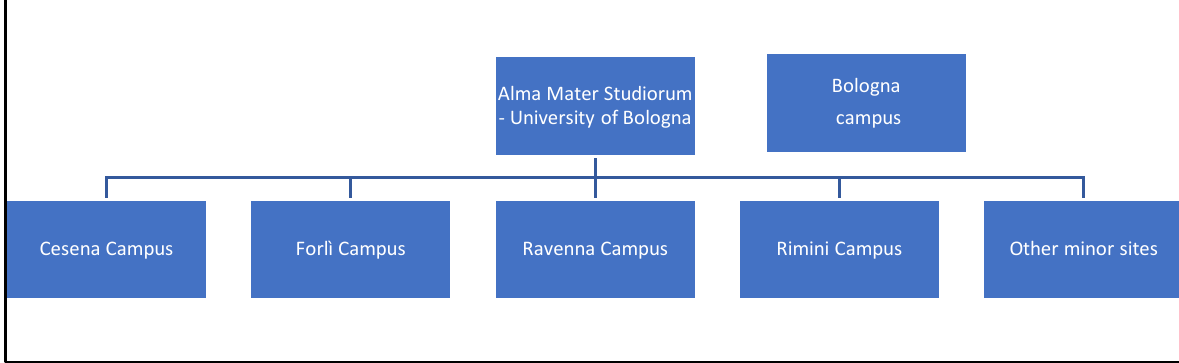
Figure 2. Organizational boundaries.